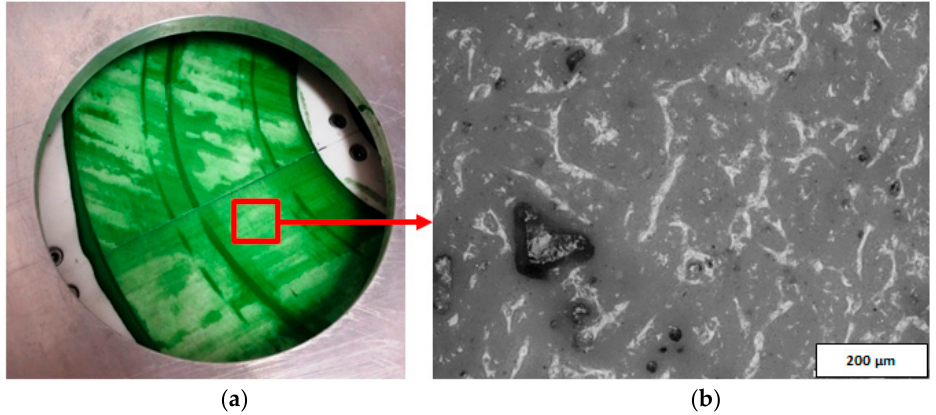
Figure 7. The active surface of the prototype tool with an abrasive suspension ( a ) containing diamond abrasive grits ( b ) after test T3.